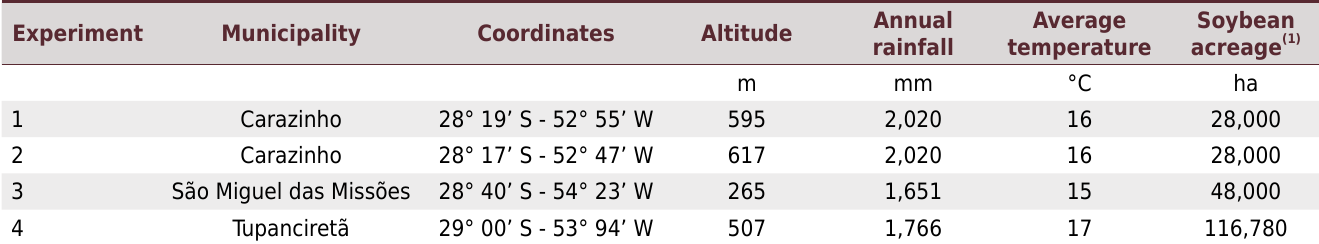
Table 1. Location of the experiments with their coordinates, altitude, annual precipitation, and soybean acreage in Rio Grande do Sul, Brazil